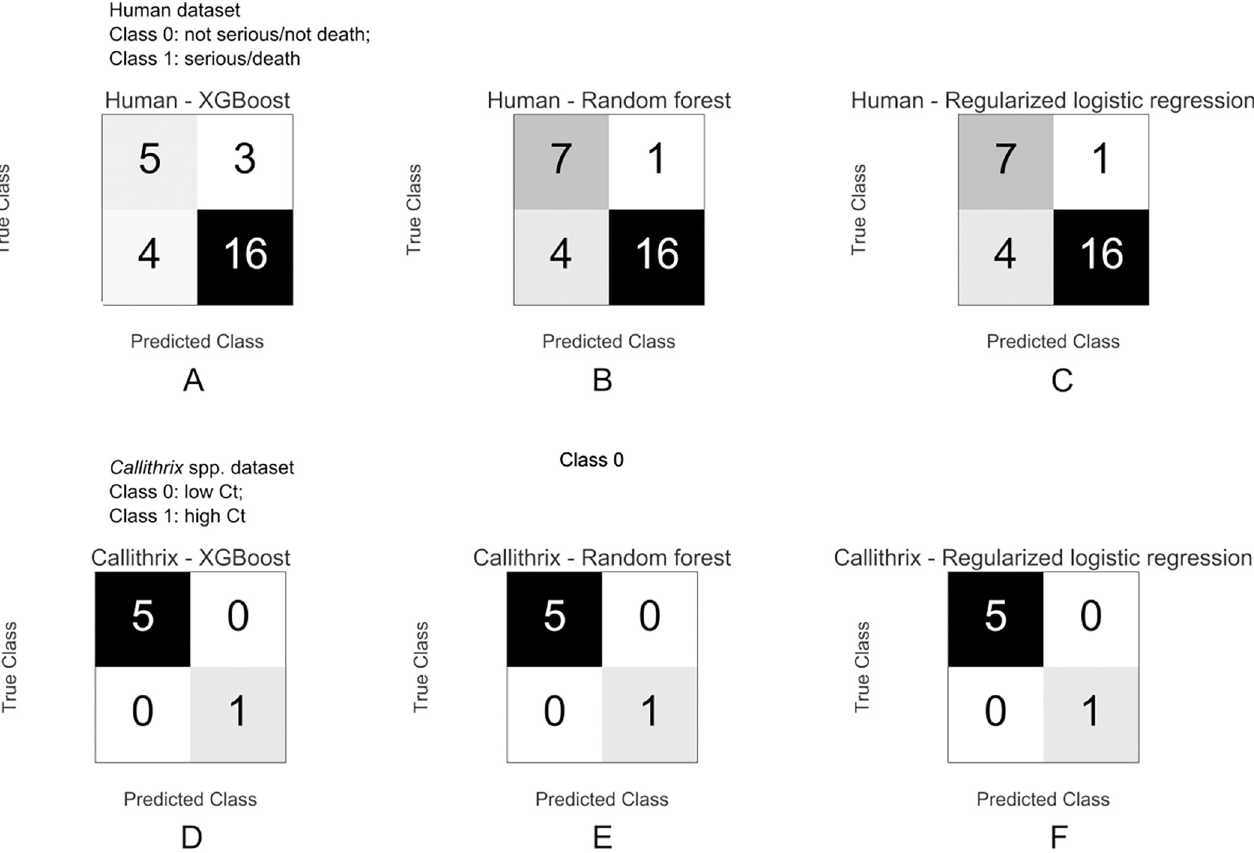
Fig 2. Confusion matrices. Each box contains one confusion matrix, which measures the performance of different machine learning algorithms over different datasets. For each matrix, the rows represent instances in the actual class, while the columns represent instances in the predicted class. Instances found along the diagonal were correctly classified, while those outside the diagonal were misclassified (false positives and false negatives). Top three matrices correspond to human test dataset and the bottom three matrices correspond to Callithrix spp. test dataset, for XGBoost, random forest and regularized logistic regression